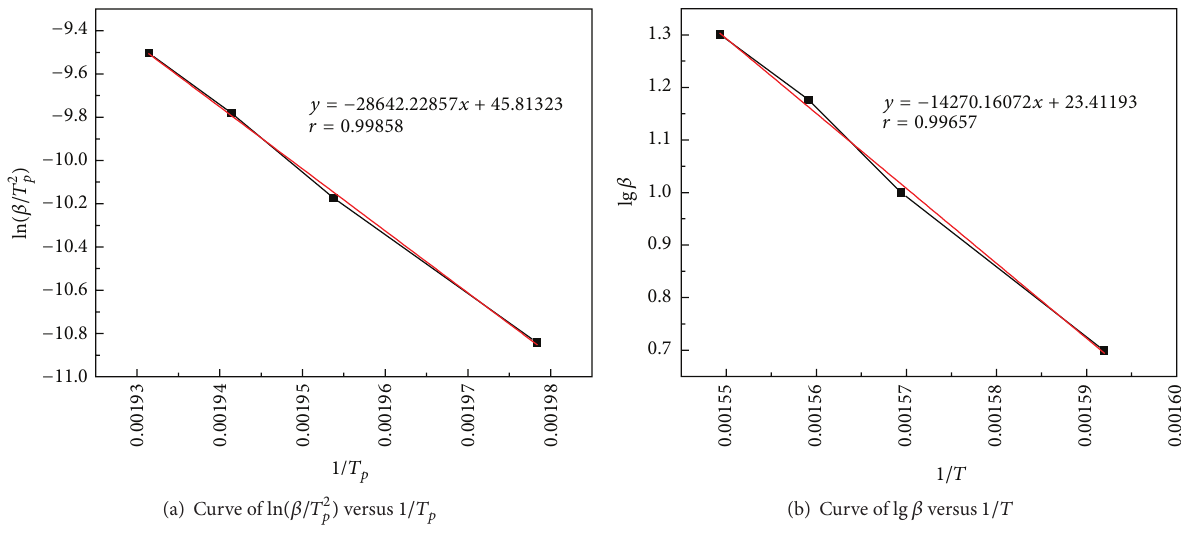
Figure 5: Linear relationship at different heating rates and 𝑇 𝑝 for the first stage.